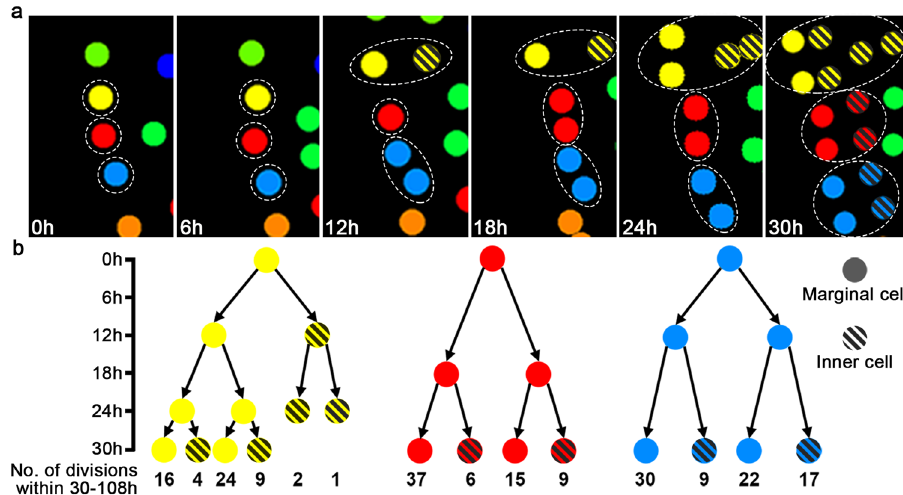
Fig. 6 The impact of lineage and position on division activities of meristem progenitor cells. a Cell division and lineage progression of three meristem progenitor cells from 0 h to 30 h. The images are part of Fig. 3a – f (0 – 30 h), highlighting the three cell lineages that contribute to the majority of cells in the meristem with the dashed lines, and labelling marginal cells with solid circles and inner cells with the circles fi lled with diagonal stripes. The complete lineage progression of the three meristem progenitor cells and their descendants (the yellow, red and blue sectors) is shown in Fig. 3a – s. b Relationships among cell lineages, cell position and quanti fi ed division events. Each circle of one family tree represents one cell at the indicated time point from 0 – 30 h. Two black arrows from one cell represent one round of cell division and illustrate the relationship between the cell and its two immediate progenies. Y -axis: the time-lapse from 0 h to 30 h. X -axis: the total number of cell division events for each cell (at 30 h) and its progenies during the following 30 – 108 h time frame (the quanti fi ed division events with the cell IDs shown in Supplementary Data 3, and cell position with IDs shown in Supplementary Fig. 19). b labels the clonally related cells with the same color in each family tree (as yellow, red and blue shown in ( a ) and highlights the positional information of each cell (as solid circles and circles fi lled with diagonal stripes shown in ( a ). During the 30 – 108 h time frame, cells from the same progenitor cell display variable division activities, and cells located at the marginal layer (solid circles) of the meristem show more division events than the cells located at the inner (or submarginal) layer (circles fi lled with diagonal stripes). All the meristem progenitor cells in the three independent gametophyte samples were analyzed (in Fig. 6; Supplementary Figs. 11 and 12), showing similar